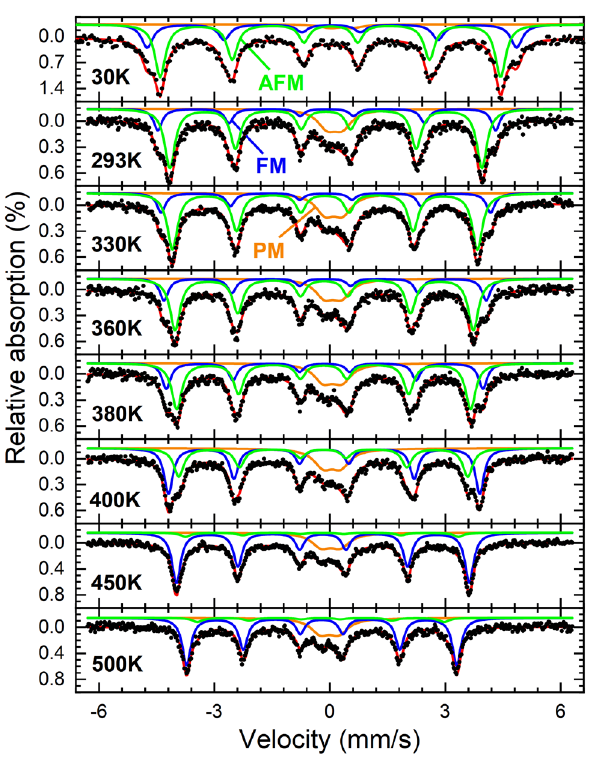
Figure 4. Relative spectral areas of individual contributions observed in the Mössbauer spectra of the annealed FeRh nanoparticles: (super-)paramagnetic doublet (orange), low-temperature AFM-state (green) and high- temperature FM-state (blue). Sigmoidal interpolation curves provide a guide to the eye. After the initial fitting of experimental Mössbauer spectra, hyperfine parameters B HF and isomer shift δ were regulated by their known temperature-dependent behavior to ensure a higher precision in the determination of the shown subspectral